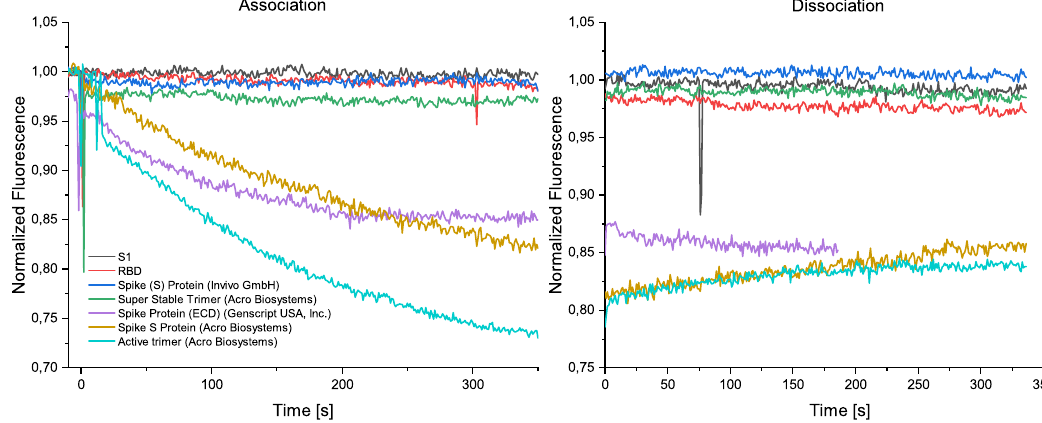
Figure 2. Binding measurements of spike protein and different subunits to SBP1 peptide. Association and dissociation of different subunits of the spike protein, as well as of full-length spike proteins with varying amino acid sequences were analyzed. All proteins were injected at a concentration of 100 nM. The SBP1-peptide-DNA- nanostructure bound the full-length spike proteins from Genscript USA, Inc. and the proteins “SARS-CoV-2 S protein” and “SARS-CoV-2 S protein, active trimer” by Acro Biosystems. The “Super Stable Trimer” by Acro Biosystms and the “Spike (S) Protein” by Invivo BioTech Services GmbH did not show any binding to the peptide. The two proteins have variations in their amino-acid sequences that seem to disturb the binding.